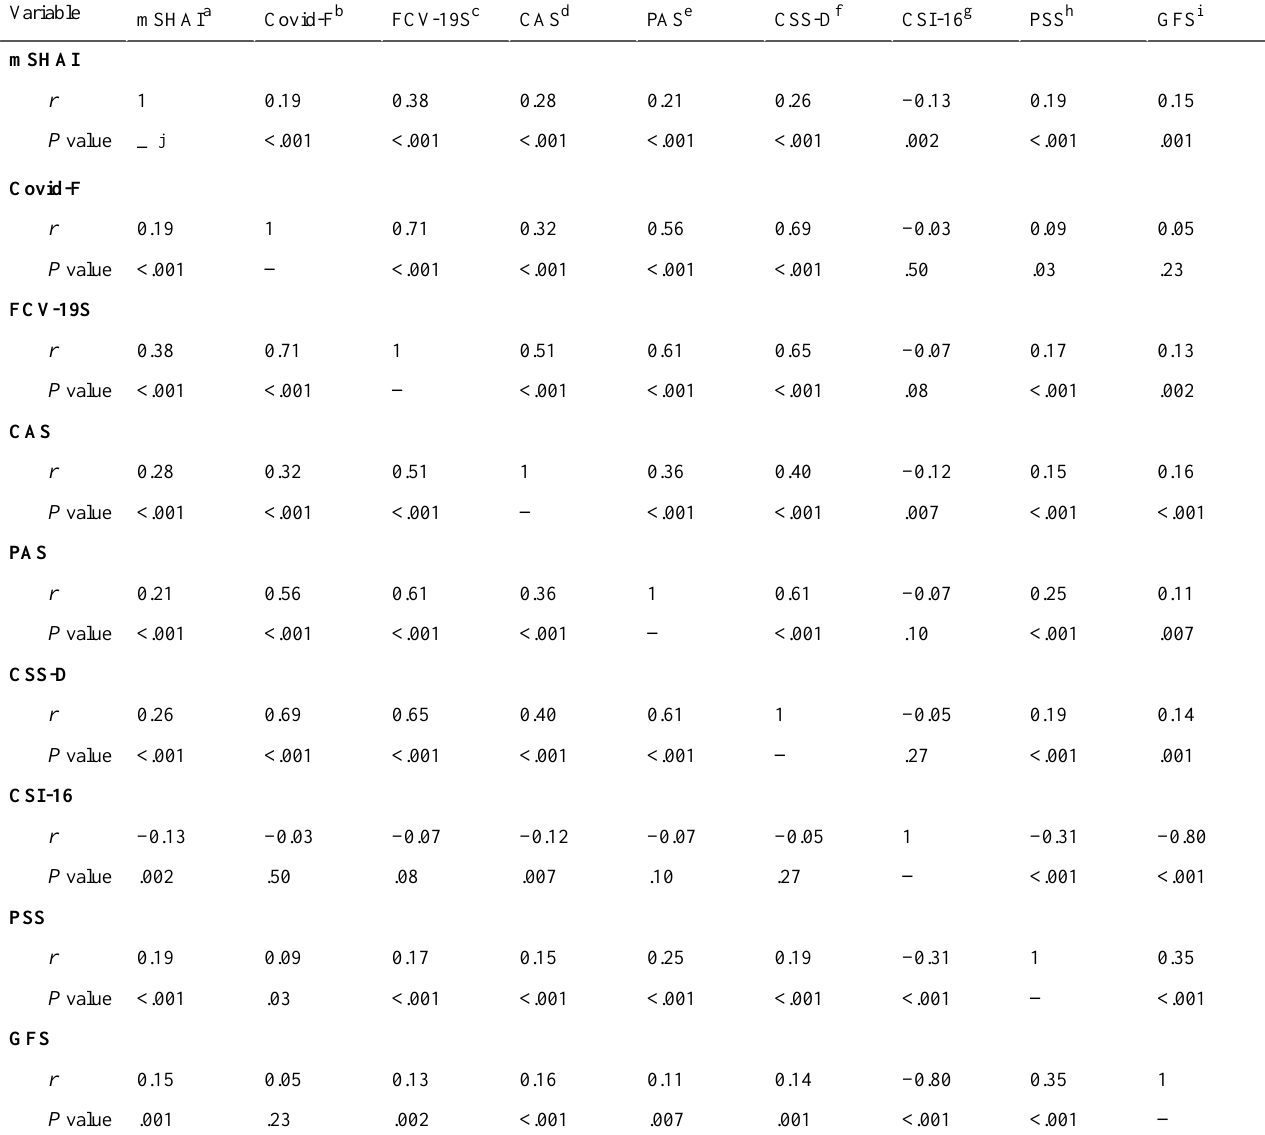
Table 4. Pearson correlations for COVID-19 anxiety scales and other measures of anxiety and family variables. N=515 for all scales, except CSI-16, for which